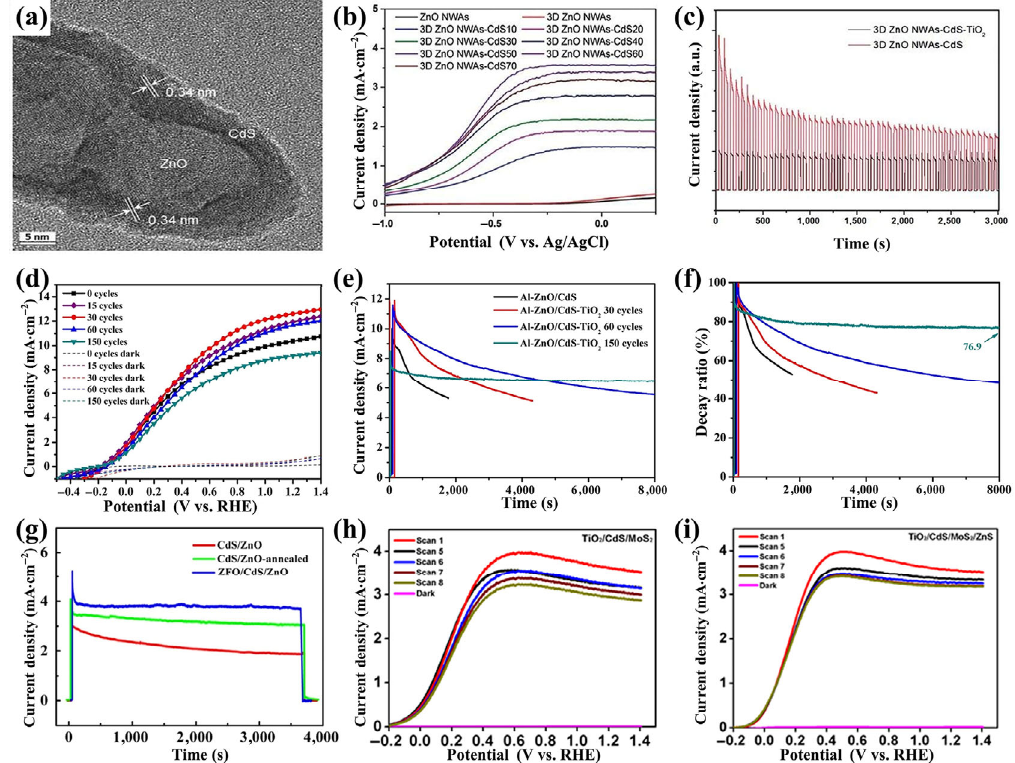
Figure 8 (a) HRTEM images of 3D ZnO NWA-CdS. (b) J – V curves of ZnO NWA, 3D ZnO NWA, and 3D ZnO NWA deposited with different numbers of CdS cycles. (c) I – T curves of 3D ZnO NWA-CdS and 3D ZnO NWA-CdS-TiO 2 in 0.5 mol·L −1 Na 2 S electrolyte under chopped illumination. Reproduced with permission from Ref. [156], © WILEY-VCH Verlag GmbH & Co. KGaA, Weinheim 2015. (d) J – V diagrams, (e) I – T curves, and (f) decay curves of Al-ZnO/CdS modified by ALD TiO 2 with different cycles. Reproduced with permission from Ref. [163], © Elsevier B.V. 2019. (g) I – T curves of CdS/ZnO, CdS/ZnO-annealed, and ZFO/CdS/ZnO photoanodes under irradiation at 70 mW·cm −2 . Reproduced with permission from Ref. [164], © Elsevier Ltd. 2016. Photocurrent density versus voltage for TiO 2 /CdS/MoS 2 , TiO 2 /CdS, and TiO 2 (h) without and (i) with ZnS. Reproduced with permission from Ref. [157], © Elsevier B.V.